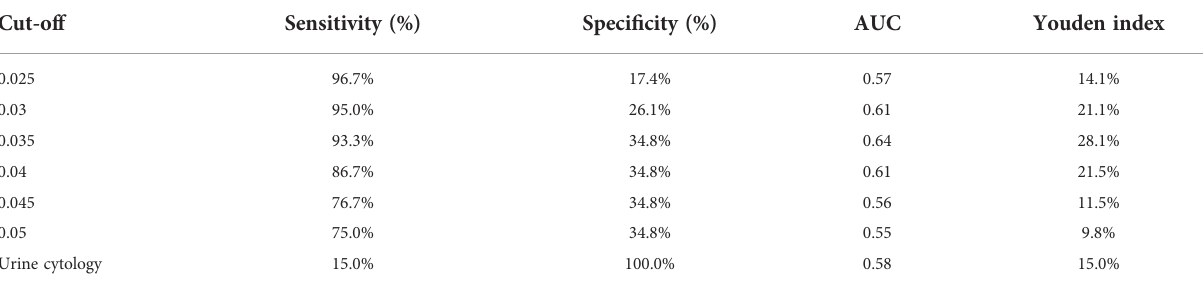
TABLE 3 Diagnostic performance of uEV a2M expression (based on ELISA) for discriminating between BC patients and non-cancer controls. A. Sensitivity, speci fi city, AUC, and Youden index according to various cut-offs of a2M levels. Data of urine cytology are also shown as a